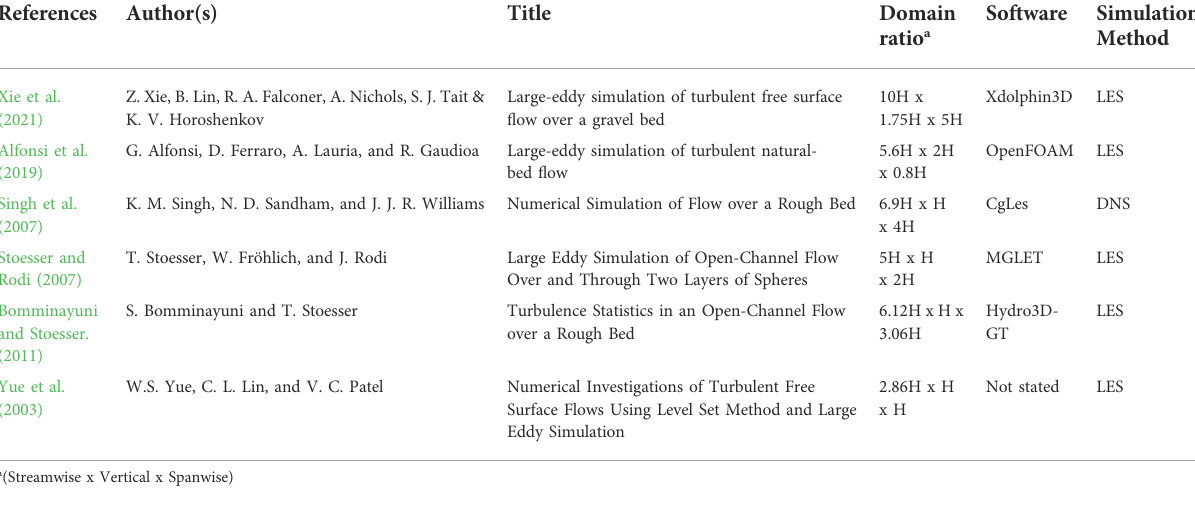
TABLE 1 Summary of rough bed simulations and domain ratio used.